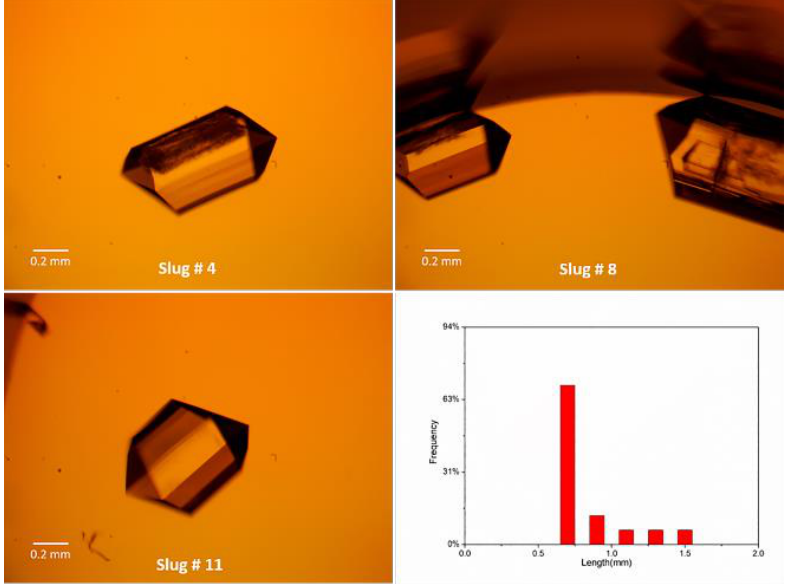
Figure 5. Representative off-line microscope images (with polarizer) of produced crystals in slugs with an aspect ratio of about 0.6 and the crystal size distribution from all off-line images. Experimental details are in Table 1, Conditions 3. Scale bar: 0.2 mm.